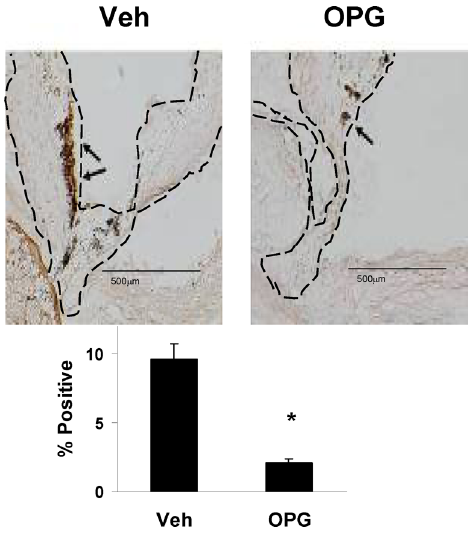
Figure 6. Immunostaining for monocyte chemo-attractant protein-1 (MCP-1) in Older LA mice. OPG decreased levels of MCP-1 in the aortic valve. N=11 (Veh) and N=6 (OPG). *p , 0.05 for Veh vs.